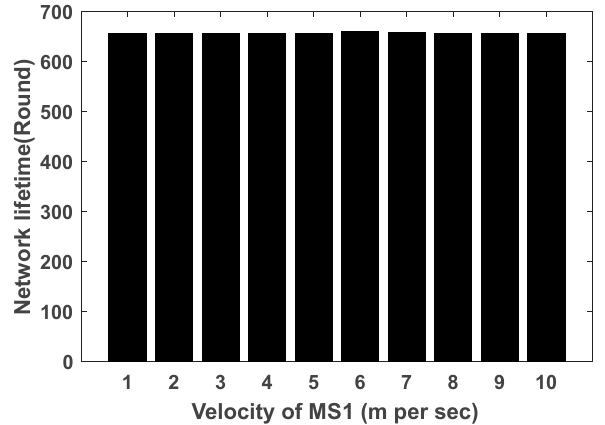
Figure 12. Network lifetime with different velocities of the innermost MS.